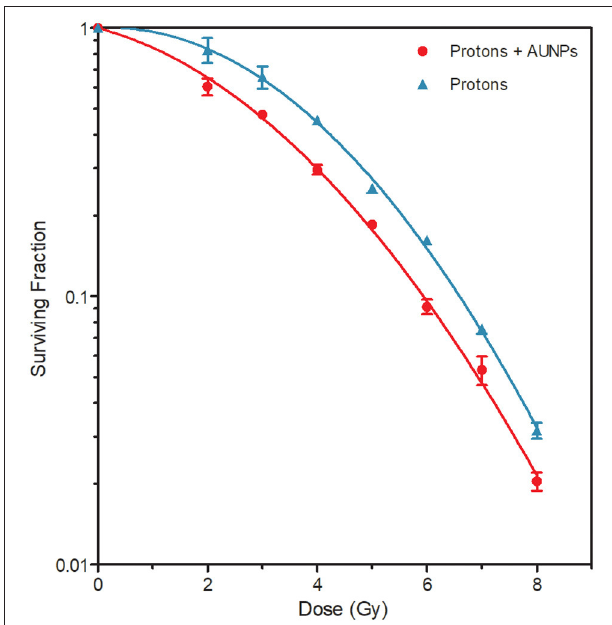
FIGURE 4 | Surviving fractions of cells after the concurrent treatment with various doses of protons, with (red) and without (blue) internalized 50nm AuNPs. All samples were irradiated in the middle position of the SOBP. The values represent the average SF and standard deviation of three biological